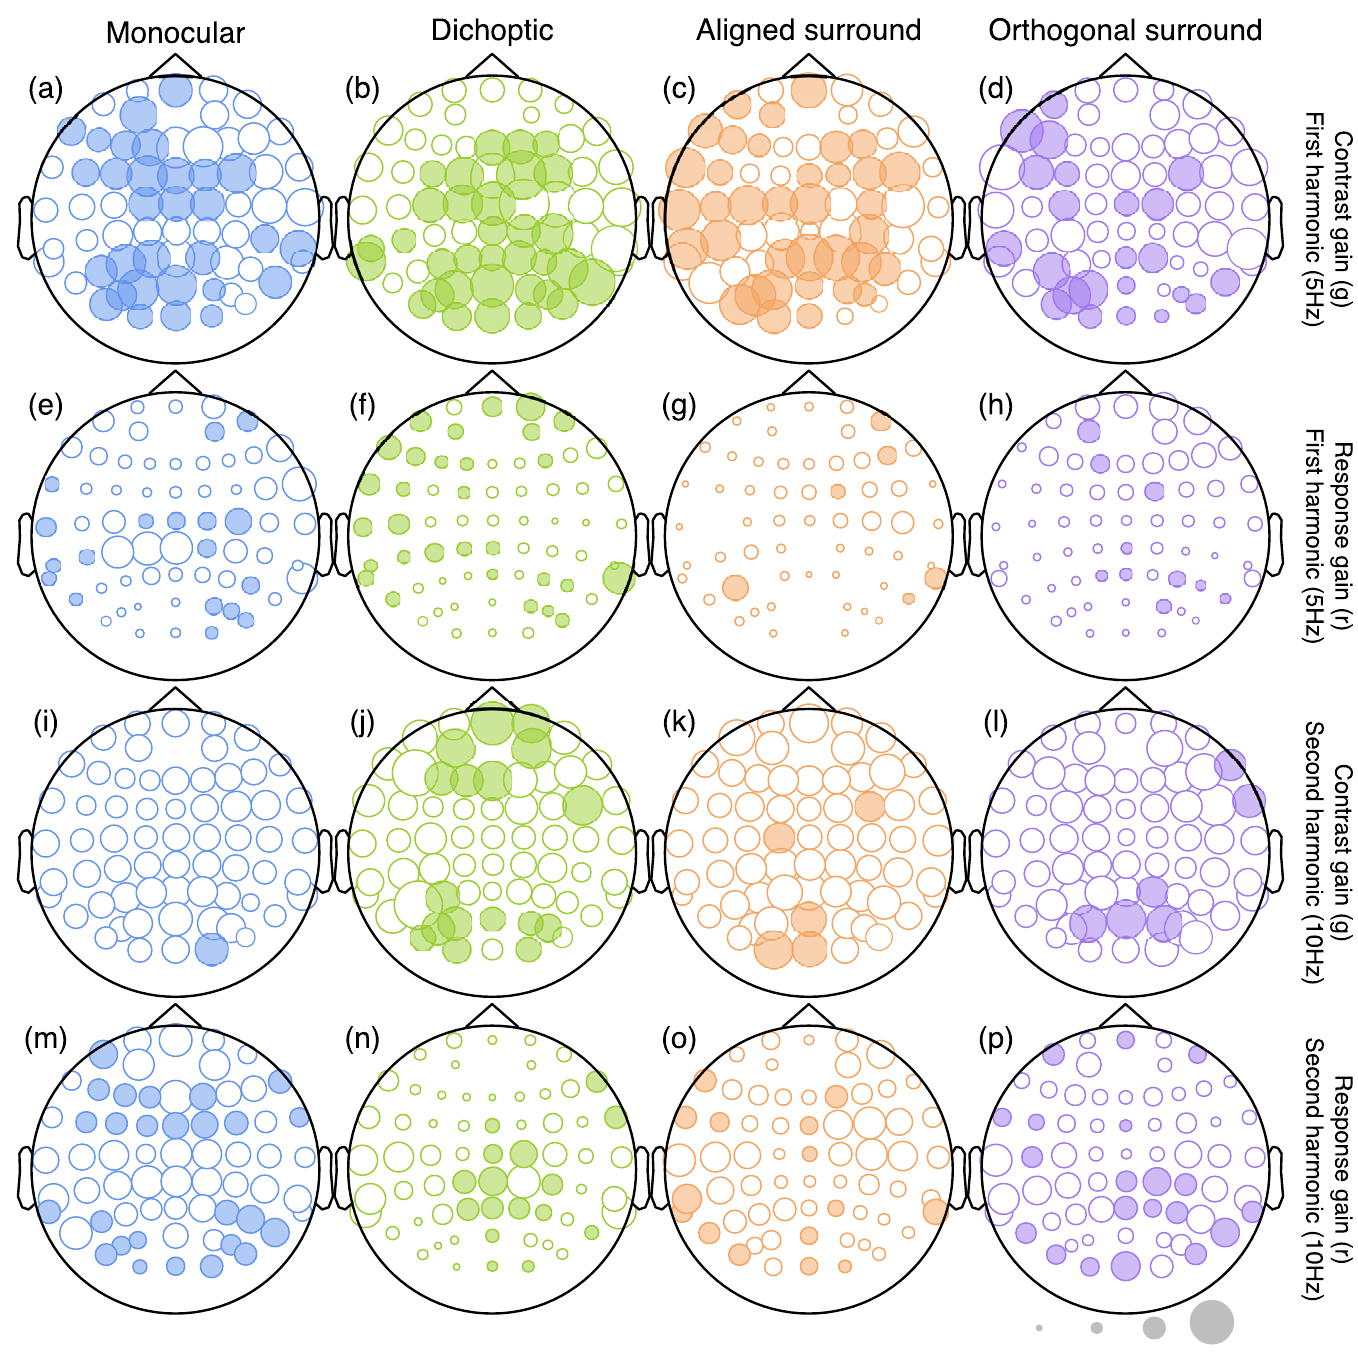
Fig 7. Scalp plots summarising the suppressive weights for contrast and response gain from the Bayesian hierarchical model, fitted to data from the high mask contrast experiment. Plotting conventions are as for Fig 5.